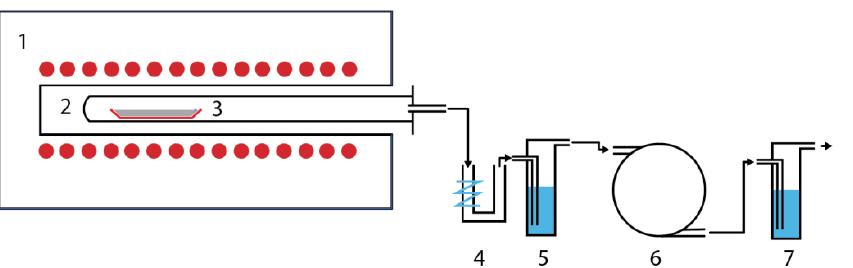
Figure 1. Experimental setup: 1. electro-resistant furnace; 2. quartz tube; 3. sample; 4. cooling of the pyrolysis oil; 5. gas purification through 1 M NaOH; 6. vacuum pump; 7. gas purification after vacuum pump.